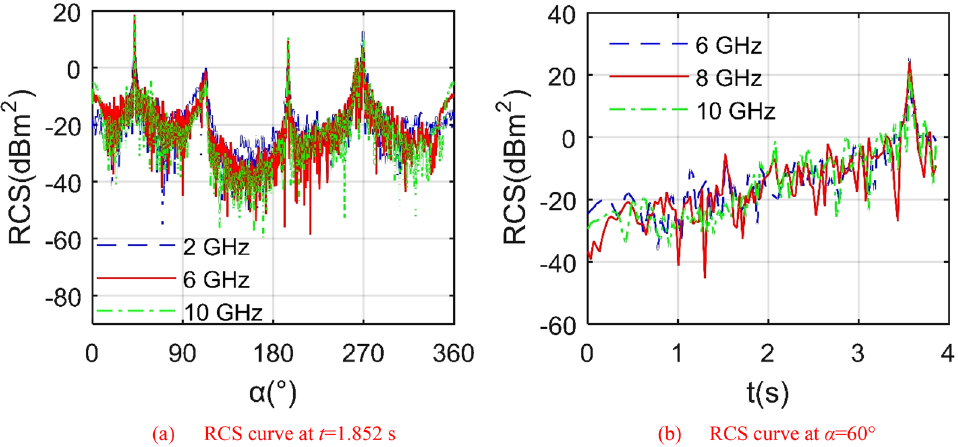
Figure 6. RCS of the outer wing 1 under different radar wave frequencies, β = 0°, ω r1 = 0.3142 rad/s.